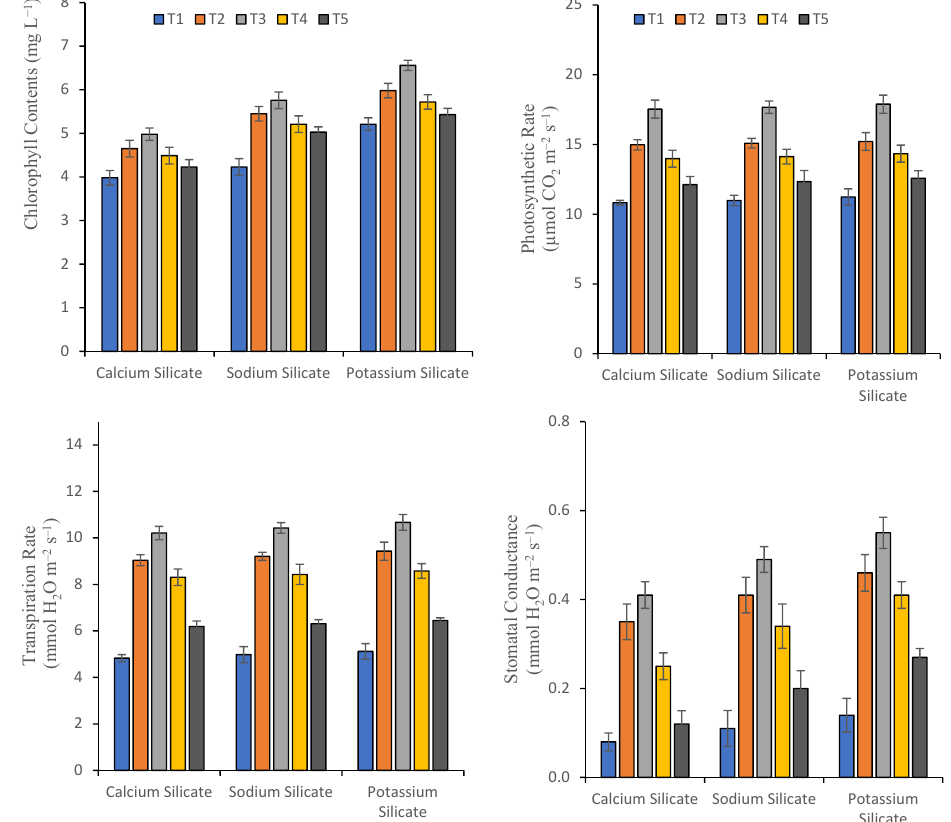
Figure 1. Effect of silicate chemicals, with various doses of foliar applications, on the photosynthetic attributes of rice grown in Cd-contaminated soil.